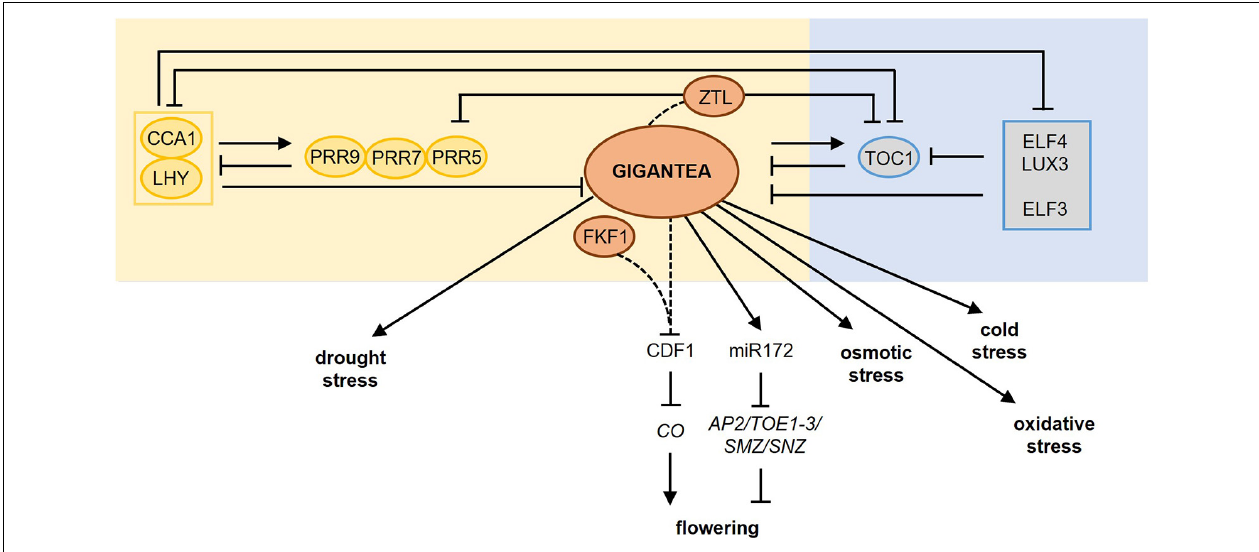
FIGURE 2 | GIGANTEA plays a central role in photoperiod sensing and mediates the impact of photoperiod on stress responses. The circadian clock is an internal time-keeping mechanism involved in photoperiod sensing. The main regulatory components of the circadian clock are shown including their mutual transcription-translation feedback loops. GIGANTEA is expressed late in the afternoon and the protein improves the stability of ZEITLUPE (ZTL) upon blue light perception thereby targeting TOC1 and PRR5 for proteasomal degradation, reinforcing the entrainment of the clock. Upon blue light perception, GI interacts also with FKF1 causing the degradation of CYCLING DOF FACTOR1 (CDF1), which is a transcriptional repressor of CONSTANS ( CO ), encoding a central protein in photoperiod-dependent flowering. In addition, GI regulates the miR172-mediated post-transcriptional downregulation of several floral repressor genes. Besides its role in photoperiod-dependent flowering, GI has a central role in the photoperiod-dependent plant responses to drought, osmotic, cold, and oxidative stress. Dashed lines mark protein–protein interactions upon blue light perception. For more detailed information about the different pathways, please refer to section “Molecular Mechanisms Involved in the Perception of Light and the Photoperiod.” AP2, APETALA2; CCA1, CIRCADIAN CLOCK ASSOCIATED1; LHY, LATE ELONGATED HYPOCOTYL; PRR, PSEUDO-RESPONSE REGULATOR, TOC1, TIMING OF CAB EXPRESSION1; ELF3, EARLY FLOWERING3; ELF4, EARLY FLOWERING4; LUX, LUX ARRHYTHMO; FKF1, FLAVIN-BINDING KELCH REPEAT F-BOX1; TOE1, TARGET OF EAT1; TOE2, TARGET OF EAT2; SMZ, SCHLAFMÜTZE; SNZ,